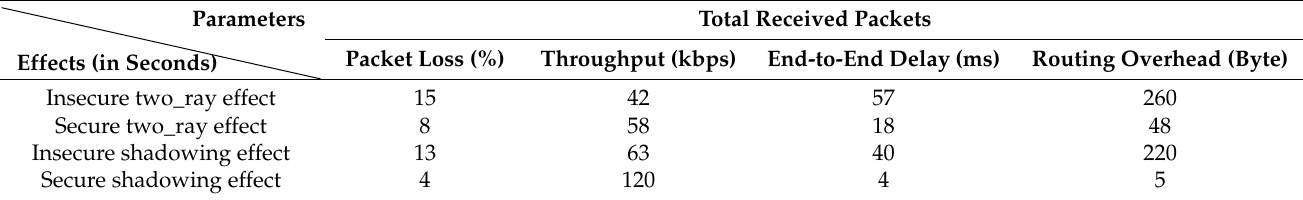
Table 9. Comparison between secure and insecure two_ray and shadow